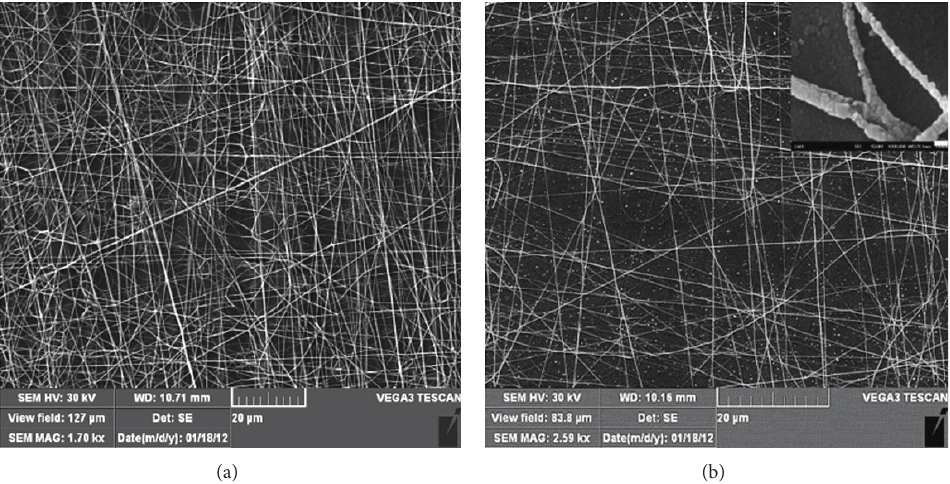
Figure 1: SEM image of (a) as-spun nanofibers of BFO/Nylon6 prior to calcination. The image indicates the formation of continuous cylindrical nanofibers. (b) BFO nanofibers after calcination at 600 ∘ C. The integrity of the nanofibers is intact after the elimination of Nylon6; the inset shows FE-SEM image of the BFO nanofibers after calcination at 600 ∘ C with the scale bar indicating 100nm. BFO nanofibers contain BFO crystallite with the mean size of 29